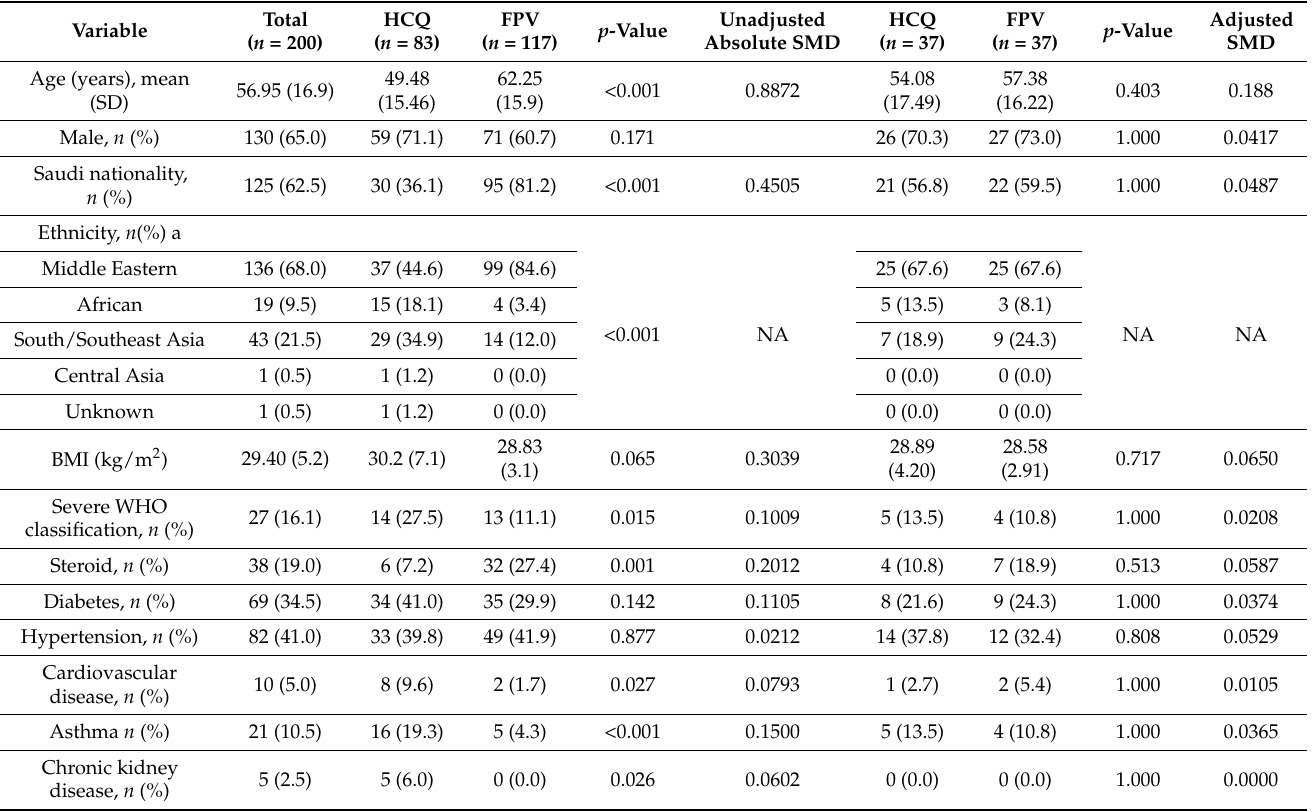
Table 1. Baseline characteristics (before and after the propensity score matching with the absolute standardized mean